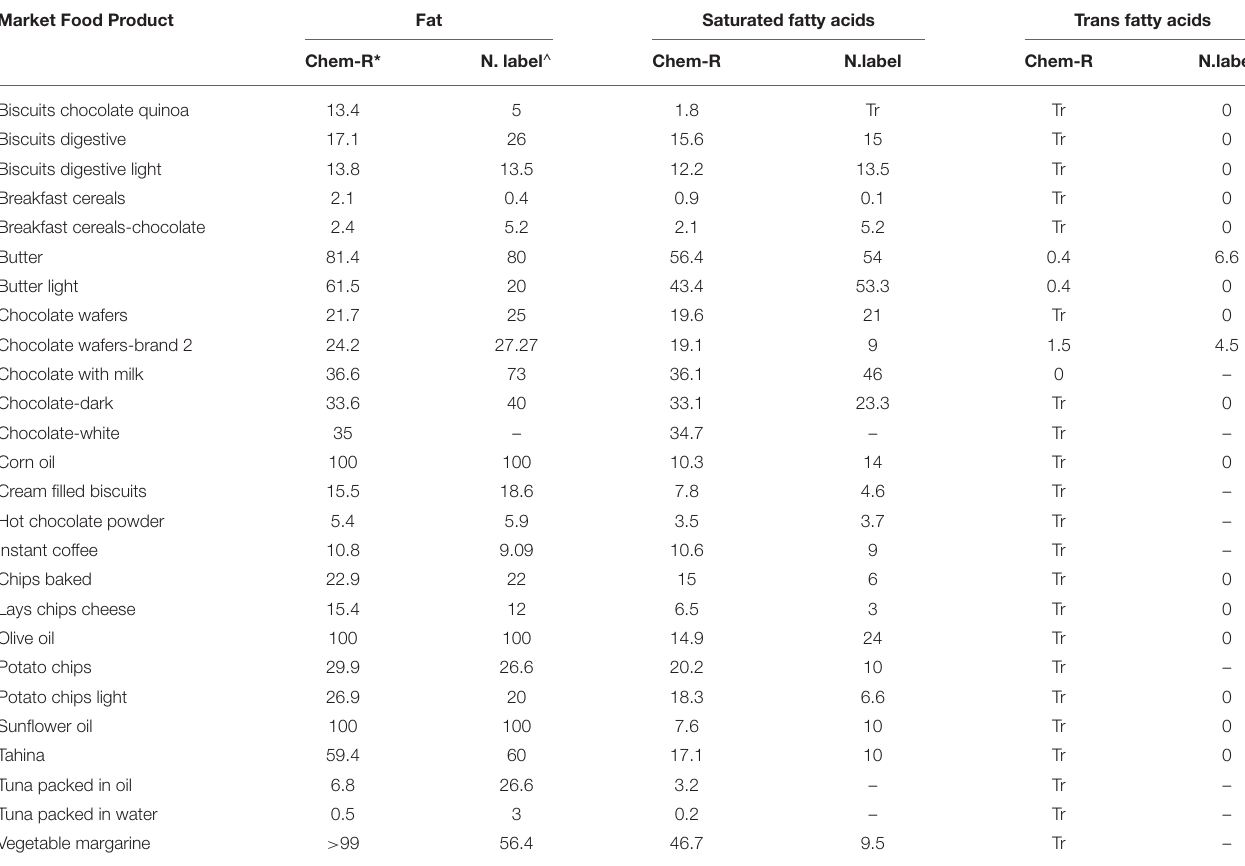
TABLE 4 | Comparison between actual nutrient analysis values of some market-processed food products and reported nutrient values on nutrition fact label. Market Food